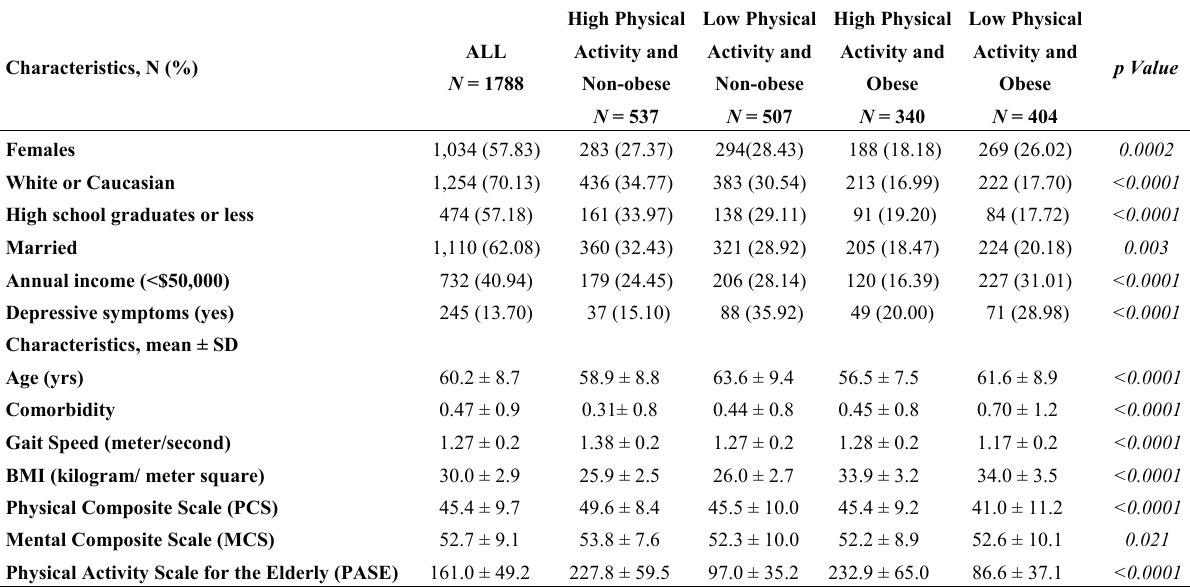
Table 1. Characteristics of the study participants